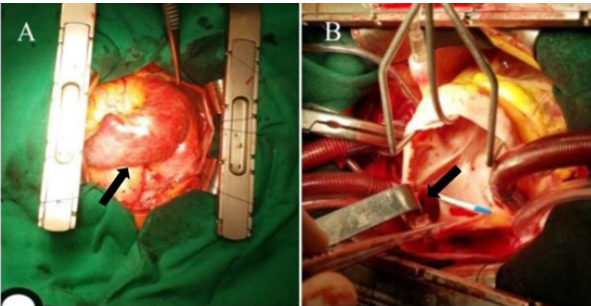
Fig. 4 - In A we observe a significant enlargement of the right chambers and the superior vena cava. In B we may observe the sinus venosus-type IAC.